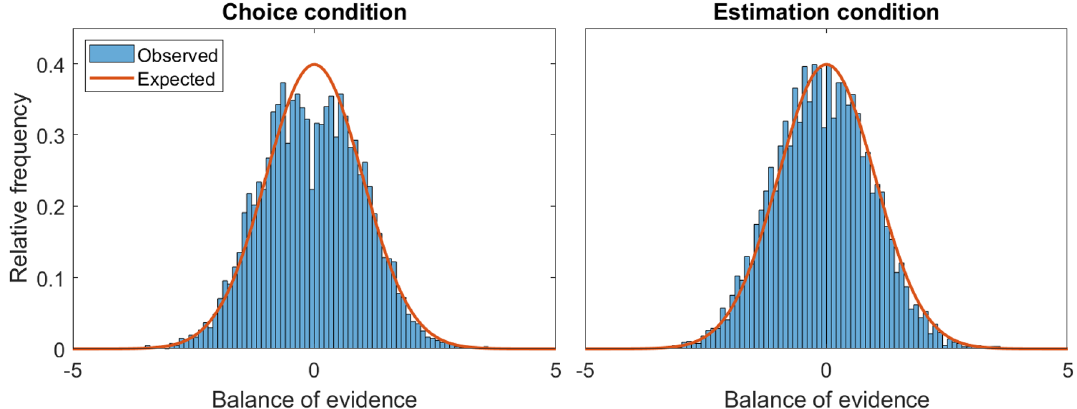
Figure 5. Distribution of information collected by participants (blue histogram) in the choice (left) and estimation (right) conditions, compared against the expected distribution that would result from unbiased, representative sampling (orange